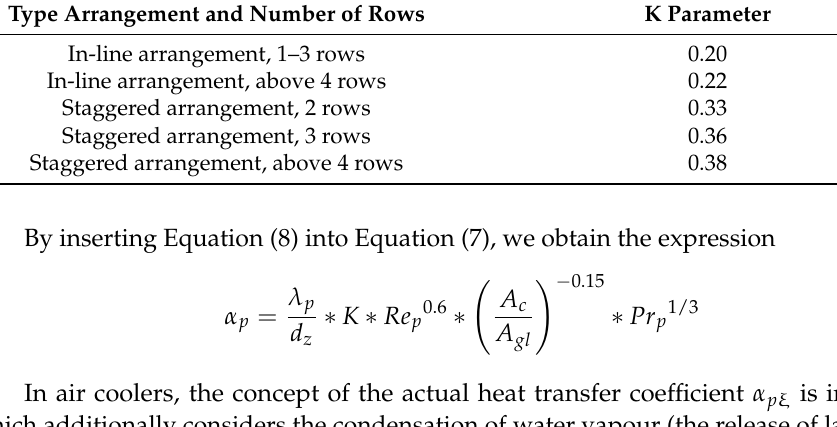
Table 1. K parameter values from Equation (8) [21]. Type Arrangement and Number of